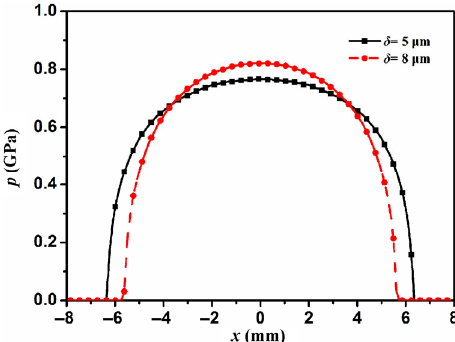
Fig. 9 Schematic of dry contact pressure for logarithmic profile roller.